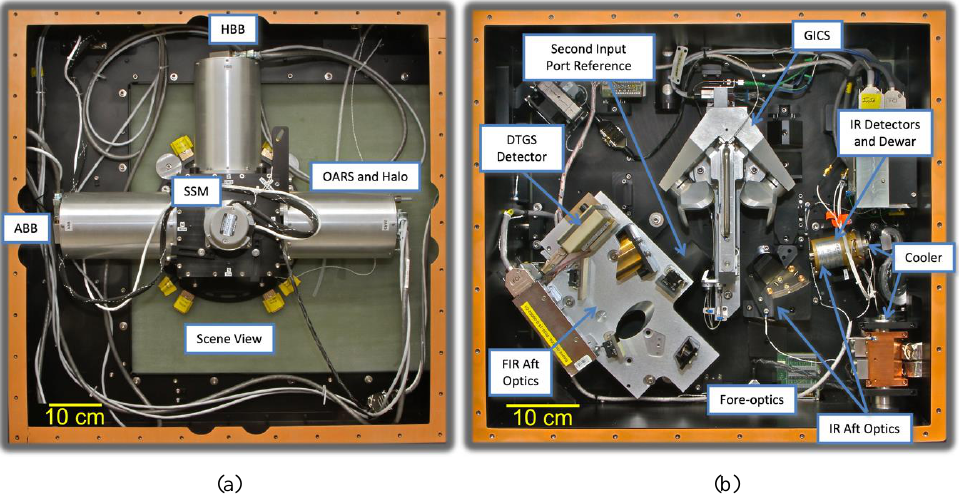
Figure 3. ( a ) Front view of the completed ARI sensor prototype, showing the Ambient Blackbody (ABB) calibration reference, the Hot Blackbody (HBB) calibration reference, and the On-orbit Absolute Radiance Standard (OARS) calibration verification blackbody; any of these sources can be selected using the scene selection mirror (SSM). The OARS includes the Heated Halo On-orbit Cavity Emissivity Monitor (OCEM), which is located inside the OARS case and not visible here. ( b ) Internal view of the completed ARI sensor prototype. Primary components are labeled and include the ABB Generic Interferometer for Climate Studies (GICS), the Stirling cooler, the fore-optics, far-infrared (FIR) aft-optics and deuterated triglycine sulfate (DTGS) detector, the infrared (IR) aft-optics and detector dewar module, and the second input port reference source. 4.1.1. Key Trade-Studies Several trade-studies were conducted during the CFTS design phase. Key studies and considerations included interferometer configuration and beamsplitter type, Technological Readiness Level (TRL) and flight heritage, optical throughput, optical stop locations, polarization, detector spectral bands, and signal chain linearity and sensitivity. The considerations particular to the interferometer core included spectral resolution and range, etendue, beam divergence, size, weight, and power, and vibration and temperature sensitivity. Cube- corner retroreflectors were selected over plane mirrors for the interferometer, based on current cube- corner manufacturing and assembly capabilities, the reduced modulation sensitivity to shear compared to tilt, and the required maximum optical path difference (MOPD) for the ARI system. Since a four-port interferometer configuration is immune to the double pass problem, a concern for the broadband coverage requirements, a four-port design was chosen. Finally, several beamsplitter